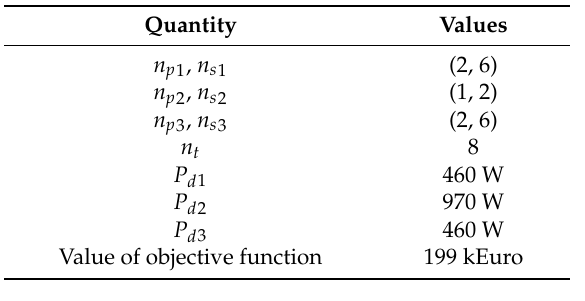
Figure 10. New power profile with integration of SC charged with photovoltaic modules.